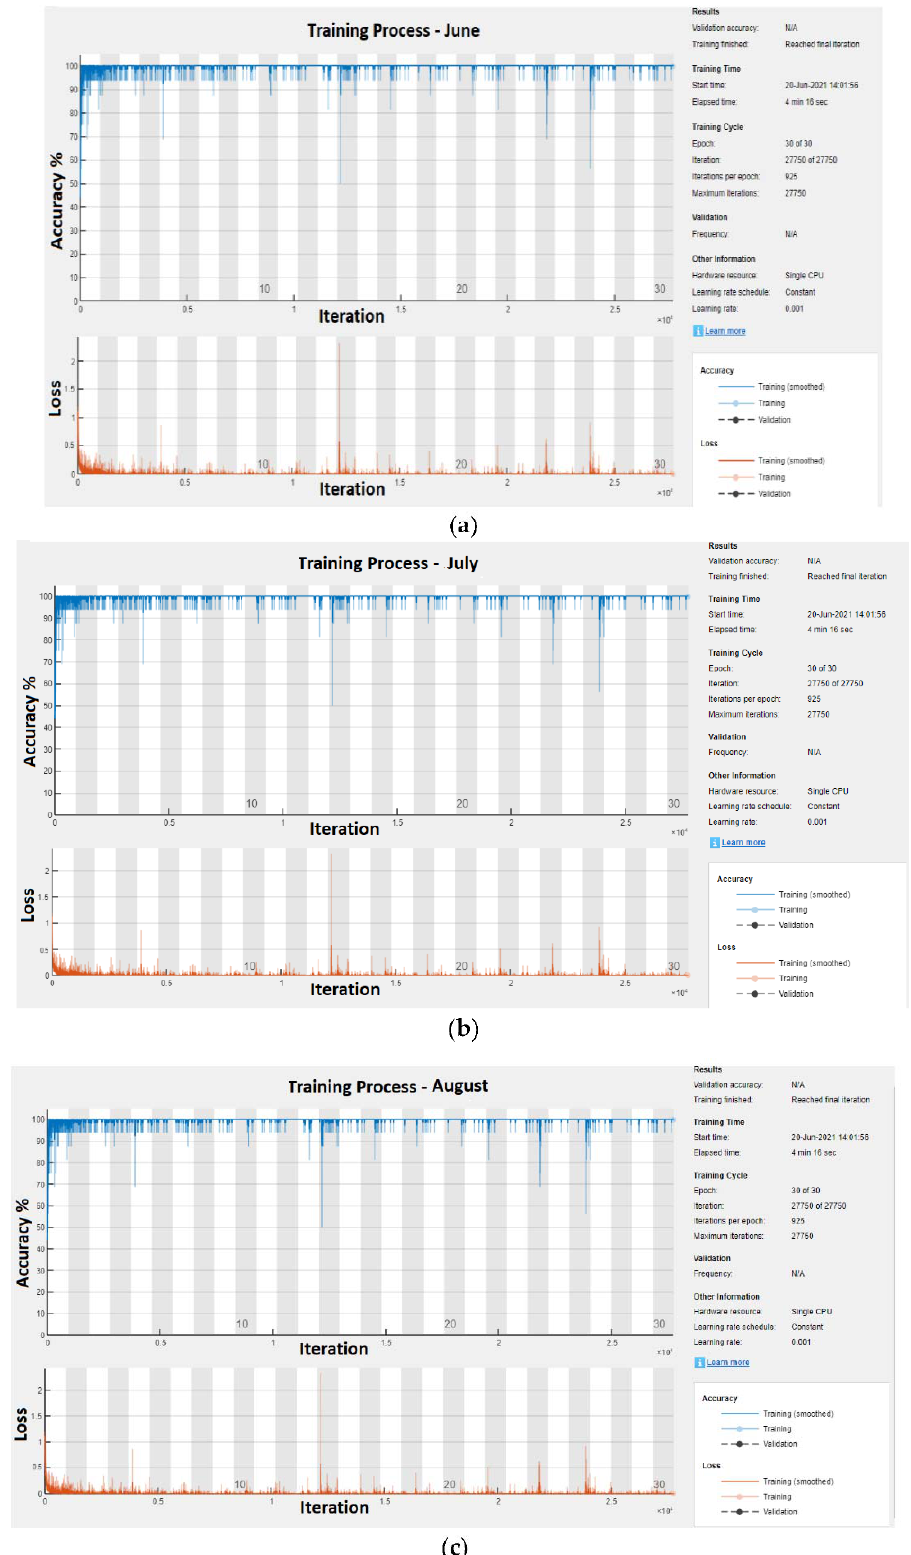
Figure 12. The training process of ( a ) June, ( b ) July, ( c ) August. Table 4. Distance relay performance.